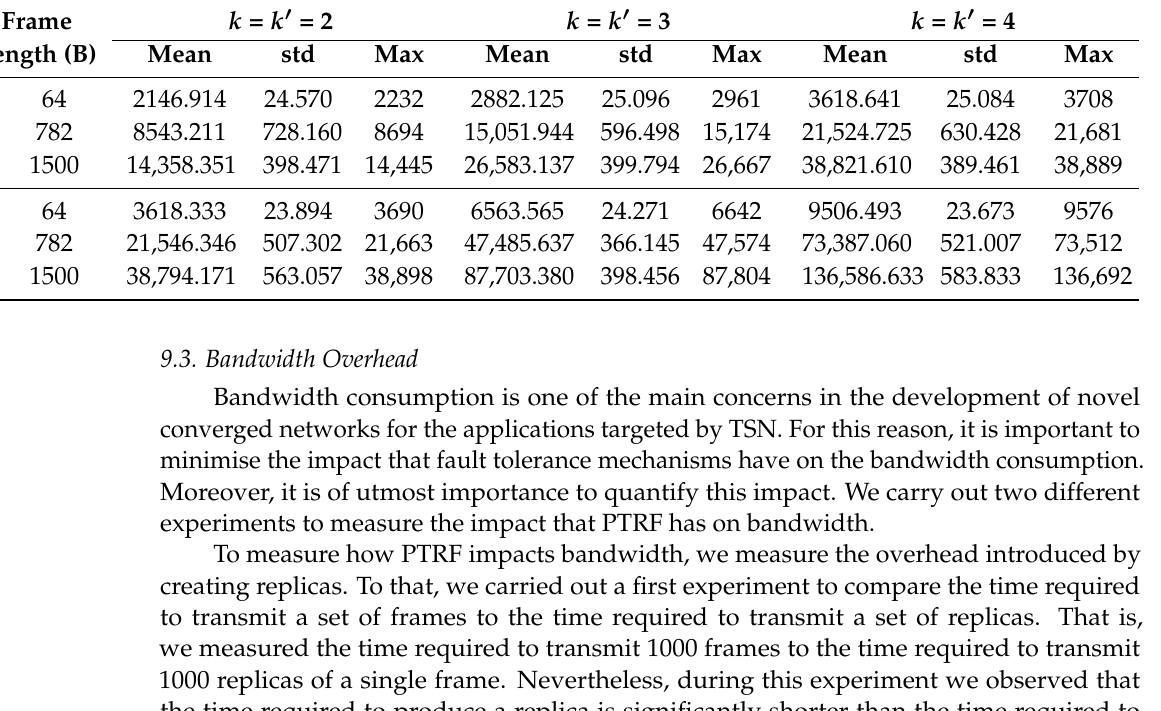
Table 5. Mean, standard deviation and maximum jitter when transmitting two, three and four replicas using approach A and approach B in a four-hop network In the presence of faults. All the results are in nanoseconds.